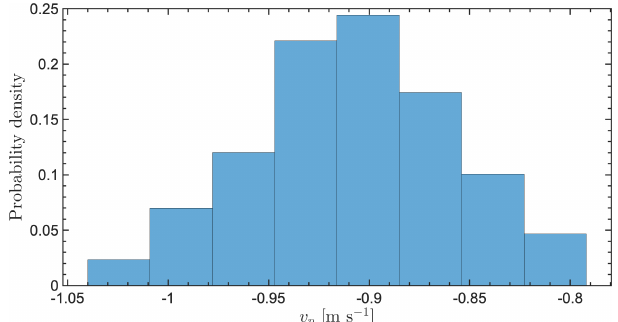
Figure A2. Simulated particle fall speed distributions for a horizon- tal wind speed of 2ms − 1 .